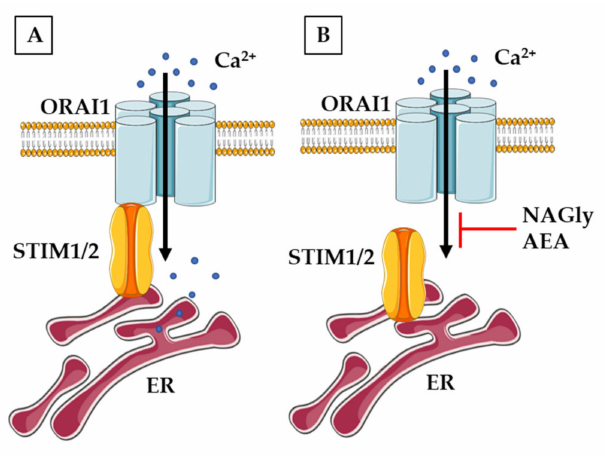
Figure 5. The overview of neuronal mechanism of non-receptor endocannabinoids action on SOCE. ( A ) The simplified view of SOCE in physiological conditions. ( B ) NAGly and AEA can block the interaction of STIM proteins with ORAI channel and inhibit